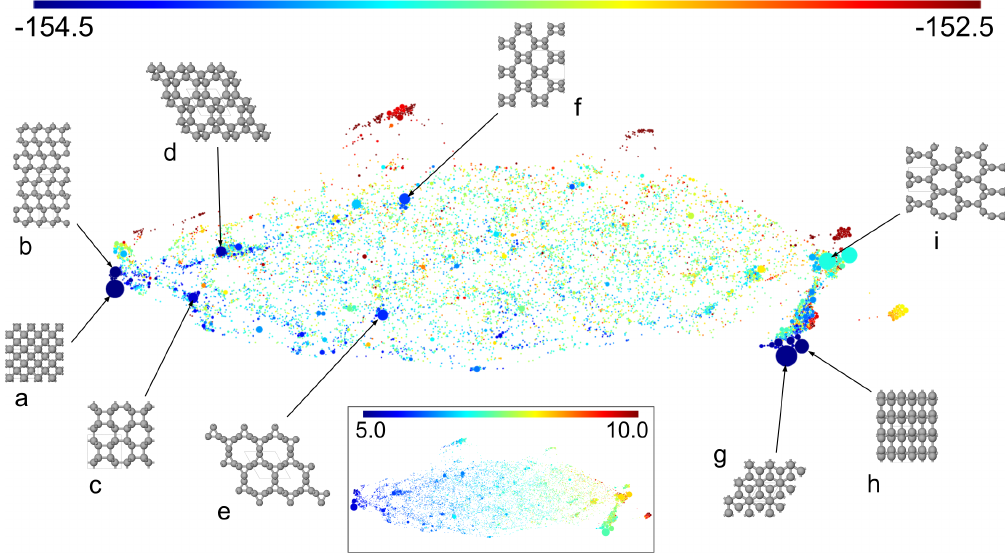
FIG. 11. 2D SHEAP map for 11370 structures of solid-state carbon, obtained with AIRSS at 10 GPa for a range of cell sizes — dataset taken from the Materials Cloud Archive [77]. Structures in the source-data represented as concatenated global SOAP vectors using ; n ; l ; σ ¼ f 2 . 4 Å ; 8 ; 4 ; 0 . 3 Å g ; f 2 . 0 Å ; 8 ; 4 ; 0 . 25 Å g . The projection uses a perplexity of 30, universal “ smart ” parameters: r cut max max with R 0 ¼ 0 . 0147 , as computed by Eq. (B1). The circles representing each structure are colored according to their energy per atom in eV; see the color bar at the top of the figure. Basin volumes are represented by the area of each circle. (a) – (n) label selected structures, including (a) diamond, (b) lonsdaleite, (d) the chiral framework structure of Ref. [79], (g) graphite, and (h) graphene layers with nongraphite packing. The inset shows the same map, colored according to volume per atom in Å 3 ; see the color bar at the top of the